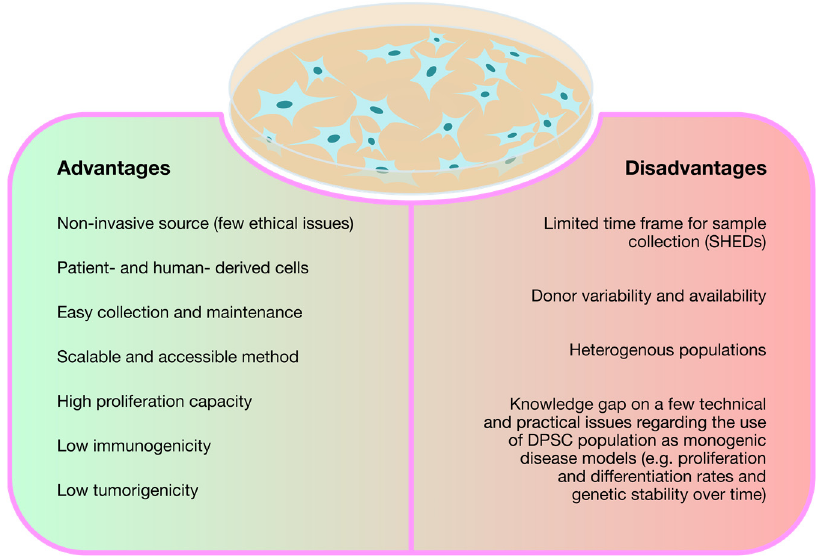
Figure 6. Advantages and limitations of dental pulp stem cells